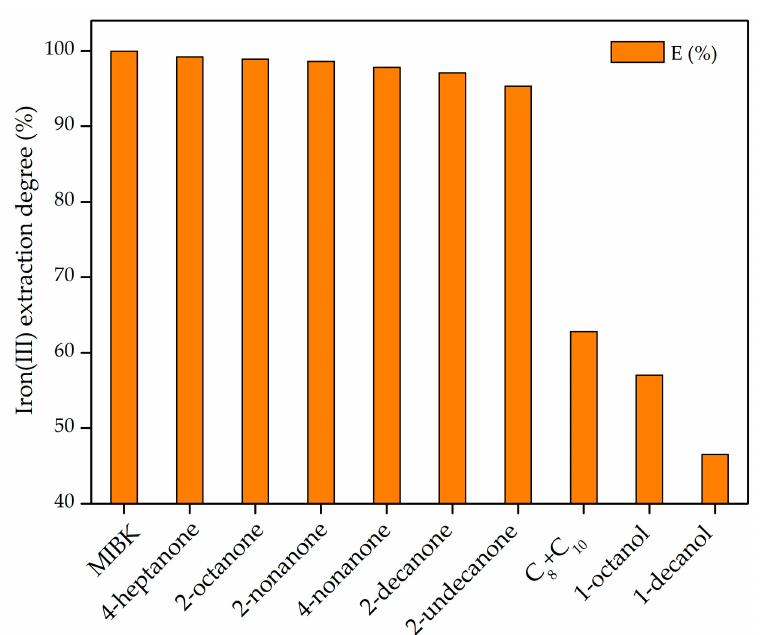
Figure 2. The dependence of iron(III) extraction degree (E) by extractant at C(HCl) = 6 M, C(Fe) = 10 g/L, O:A = 1:1.